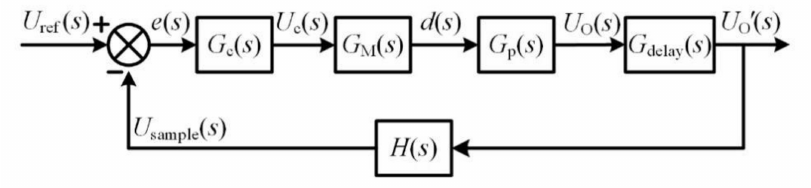
Figure 5. The voltage and current waveforms at each node of the system in an aligned